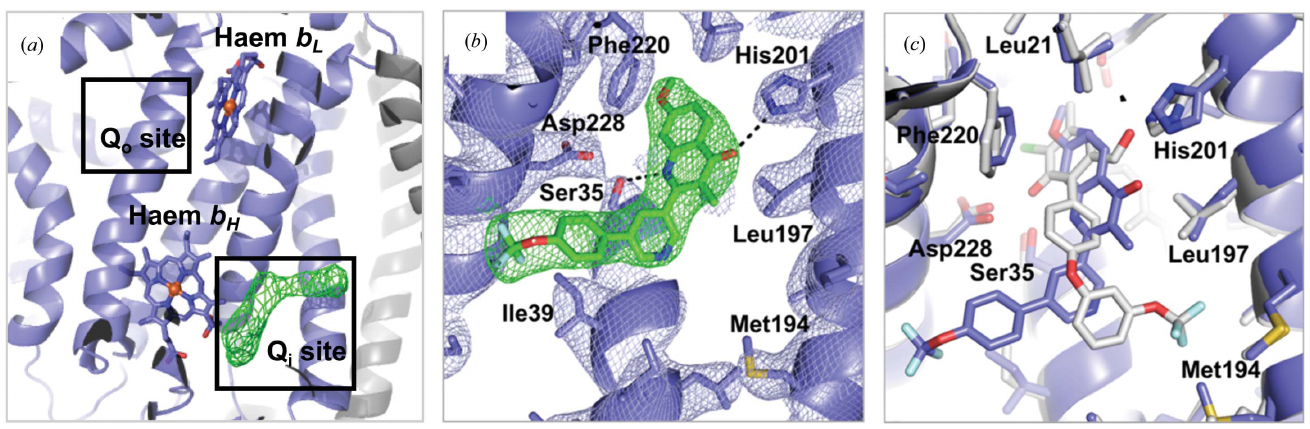
Figure 1 Crystal structure of the Q i site of bovine bc 1 with the SCR0911 inhibitor bound. ( a ) Cartoon representation of cytochrome b (blue) and the Rieske protein (grey). The Q o and Q i sites of the cytochrome b subunit are highlighted in black boxes. Haems b L and b H are shown as blue sticks. Omit F o (cid:5) F c electron density (in green) is contoured at the 3 (cid:3) level, showing density for the SCR0911 inhibitor. ( b ) SCR0911 inhibitor bound in the Q i site. Residues and inhibitor are shown as sticks. The 2 F o (cid:5) F c electron-density map is contoured at the 1 (cid:3) level, with the inhibitor density coloured green and the protein density in purple. Hydrogen bonds between inhibitors and residues are illustrated by black dashed lines. ( c ) The crystal structures of the Q i site in bc 1 –SCR0911 (purple) and bc 1 –GSK932121 (grey) have been superimposed, showing the different binding modes of the pyridone (GSK932121, grey) and quinolone (SCR0911, purple)